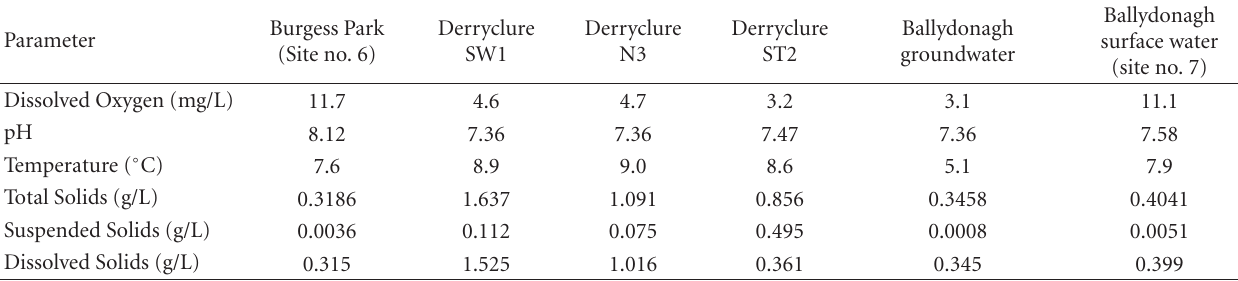
Table 8: Field results of master variables for leachate sample locations, 2005.